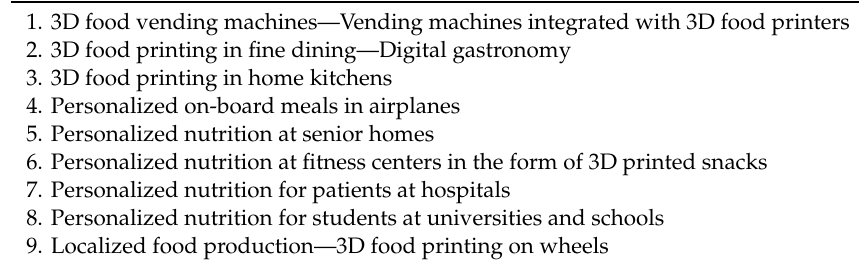
Table 4. Use-cases for 3D food printing identified during the exploratory